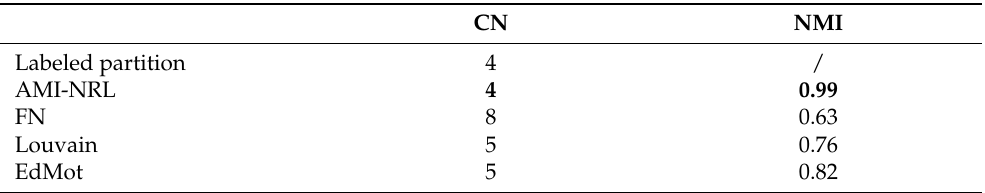
Table 9. Result comparison of AMI-NRL and the other community detection algorithms on LFR benchmark (mu = 0.3).